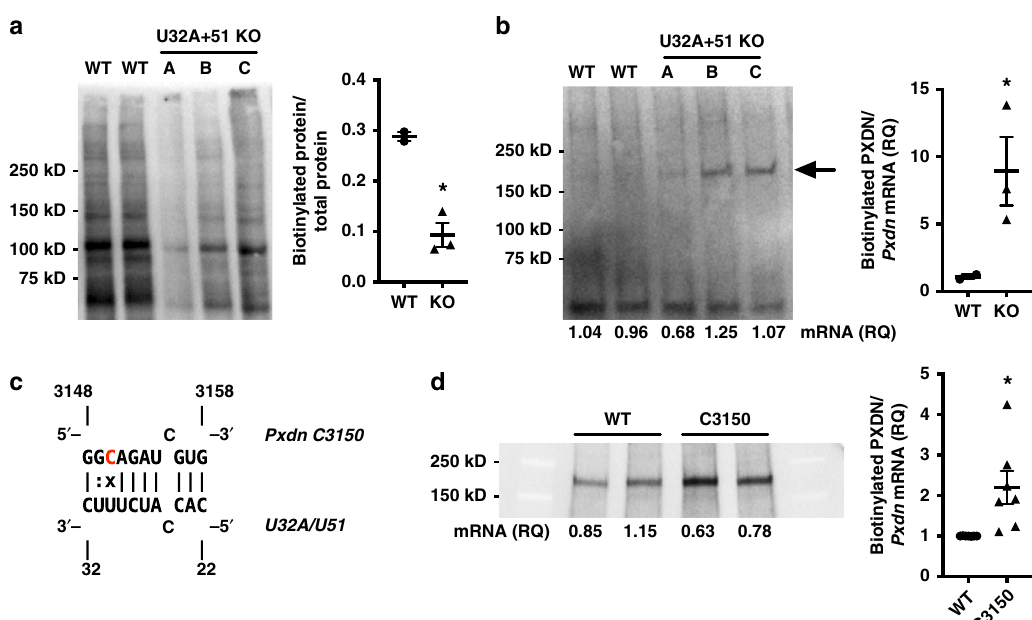
Fig. 4 Nm modi fi cation of mRNA codon inhibits translation. a , b 293T WT and U32A + U51 KO cells transfected with myc-tagged Pxdn and labeled with AHA for 4 h. Plots show mean ± SEM. a AHA-labeled protein detected by biotin click-labeling. Plot shows quanti fi cation, normalized to total protein (* p = 0.0083). b PXDN protein captured by anti-myc IP, then click-labeled with biotin and detected by immunoblotting (arrow). Plot shows quanti fi cation of biotinylated PXDN normalized to relative mRNA expression and total biotinylated protein from Fig. 4a (* p = 0.0485). c Mutation of Pxdn A3150 to C3150 (red) creates a base-pair mismatch at the putative methylation site. d 293T WT cells were transfected with myc-tagged Pxdn WT or C3150 mutant. Cells were AHA labeled for 4 h, then nascently translated PXDN protein was captured, biotinylated, and quanti fi ed as in b . n = 7/group, across three independent experiments. Plot shows mean ± SEM, * p = 0.0119 vs. WT by unpaired t -test. Representative immunoblot shown, including relative